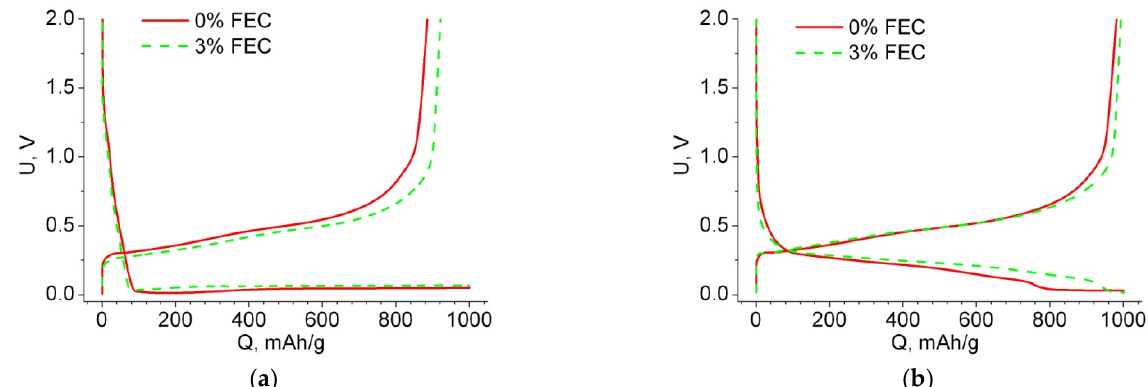
Figure 4. Voltage profiles of the first ( a ) and second ( b ) cycles for samples with 0% and 3% FEC.